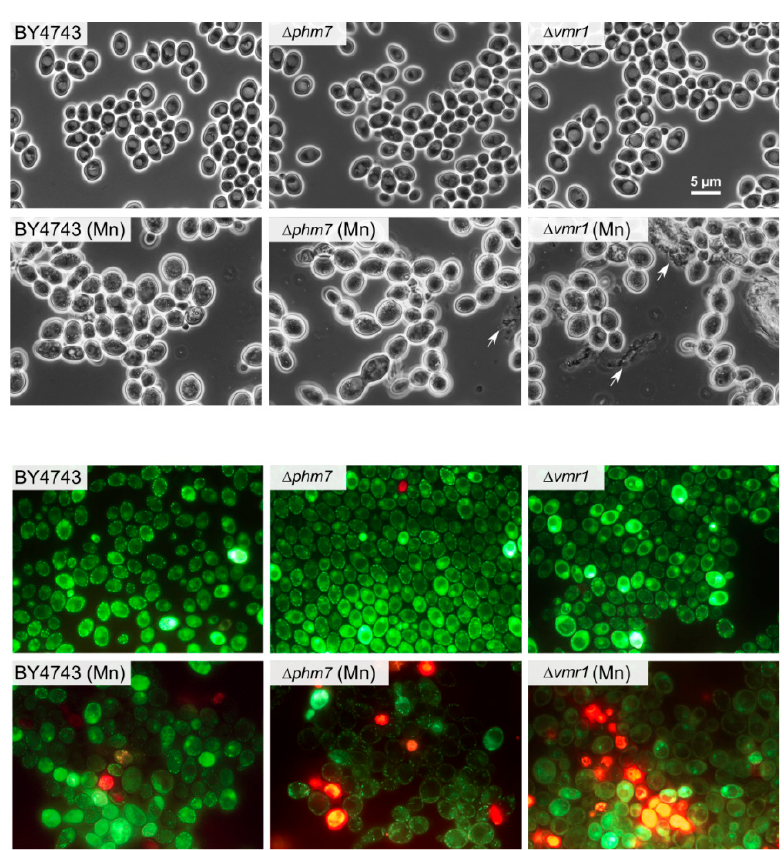
Figure 6. The micrographs of the cells of the parent BY4743 strain and Δ phm7 and Δ vmr1 knockout strains of S. cerevisiae cultivated in YPD medium with (Mn) and without 5 mM MnSO 4 to the stationary growth stage (72 h). Top—phase contrast, bottom—LIVE/DEAD Fungal Light Yeast Viability Kit staining.